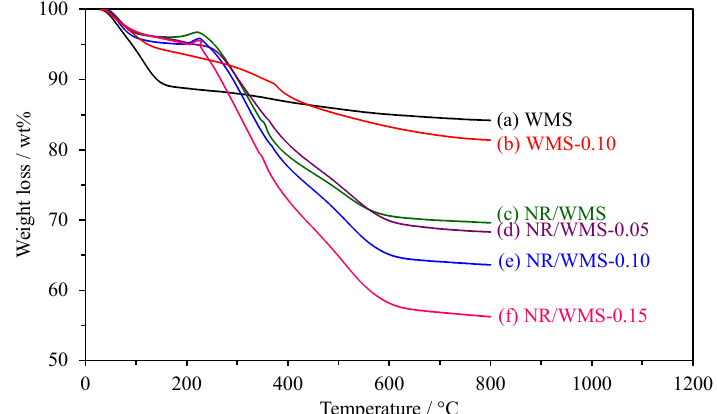
Figure 3. Weight loss curves of the WMS and NR/WMS prepared with different amine loadings.